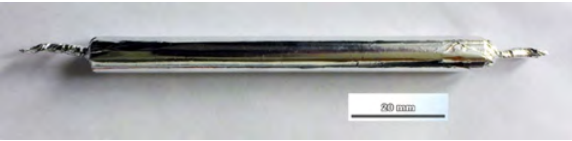
Figure 2. Sample packed in aluminum foil.